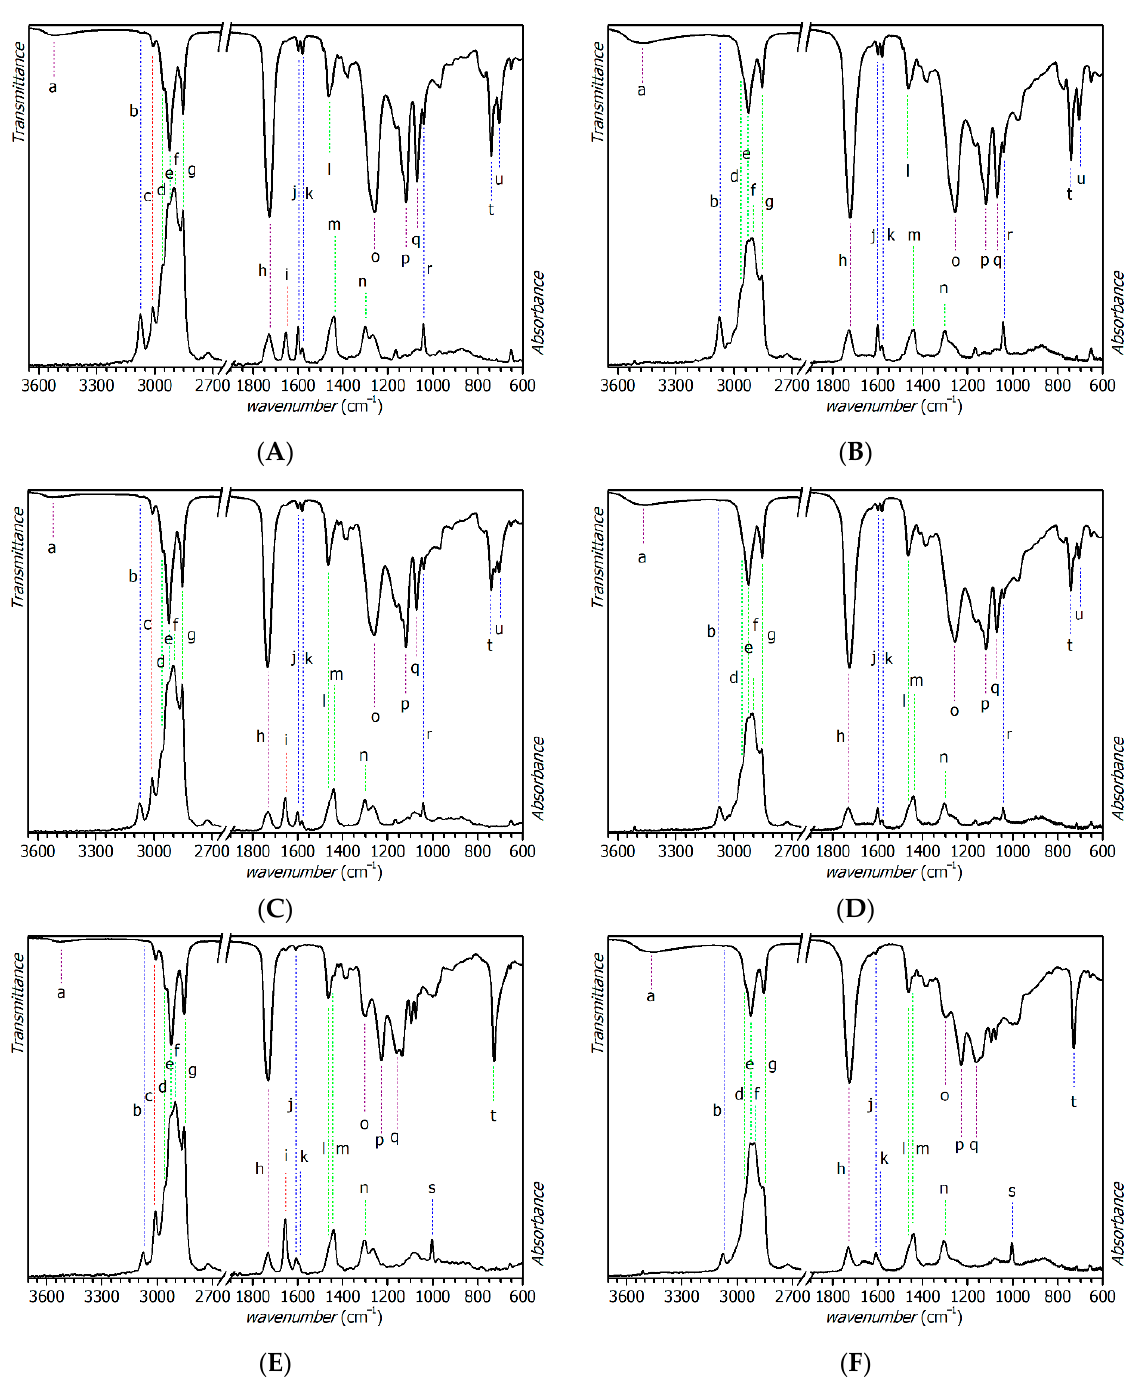
Figure 3. Infrared (top) and Raman spectra (bottom) of formulations: ( A ) fresh S622; ( B ) cured S622; ( C ) fresh FP07; ( D ) cured FP07; ( E ) fresh TI870; ( F ) cured TI870. Colors: red—bands disappearing upon curing; green—aliphatic chains; blue—aromatic rings; purple—ester and OH functions.